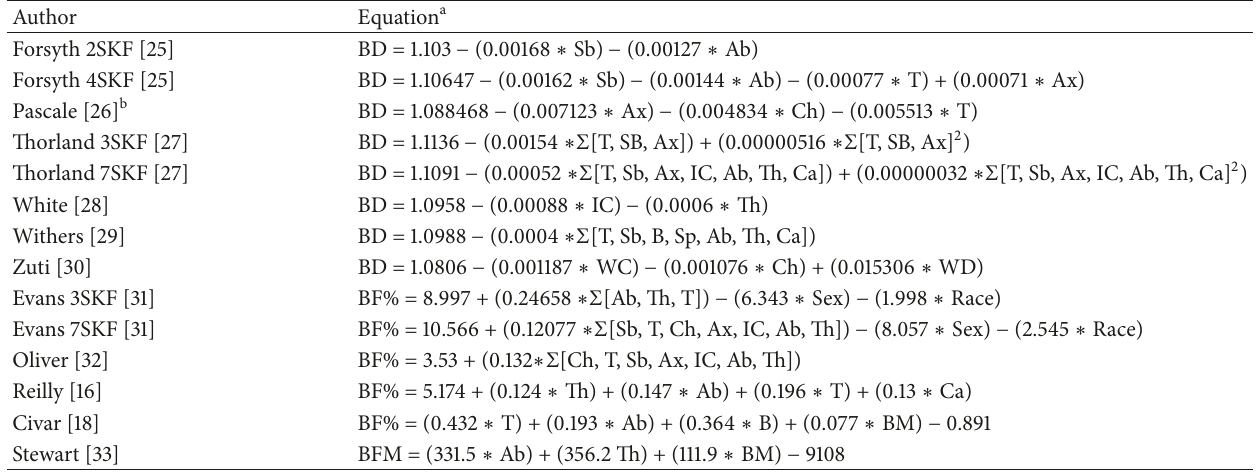
Table 1: Analyzed anthropometric equations (developed in athletic